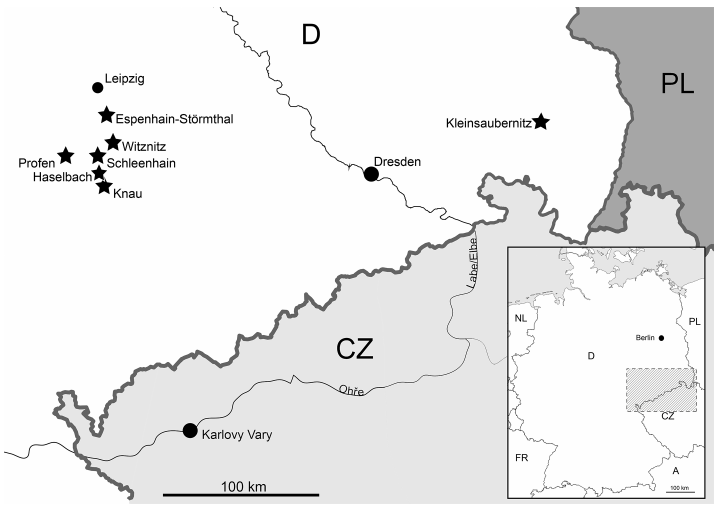
Figure 2. Sites (asterisks) of Eotrigonobalanus furcinervis -containing fossil taphocoenoses in central and east Germany considered in the present investigations. Note: the Schleenhain and Haselbach opencast mines revealed taphocoenoses in four and two distinct lithostratigraphic positions respectively (see also stratigraphic chart in Fig. 3). Map legend: D = Germany, CZ = Czech Republic, PL = Poland, FR = France, NL = the